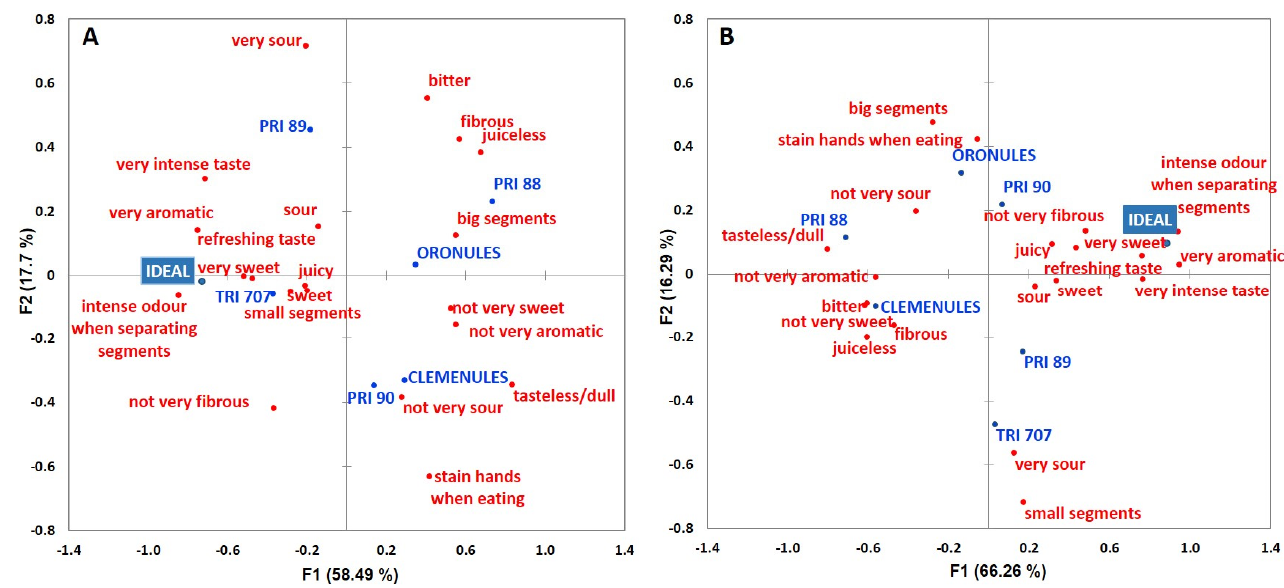
Figure 1. Correspondence analysis for Cluster 1 ( A ) and Cluster 2 ( B ).